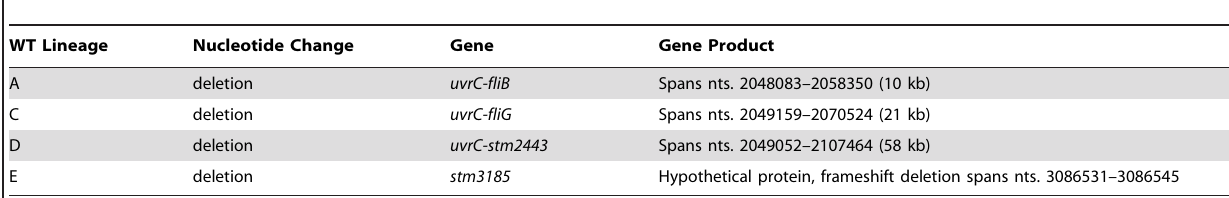
Table 2. Summary of the genetic changes specific to the wild-type lineages.